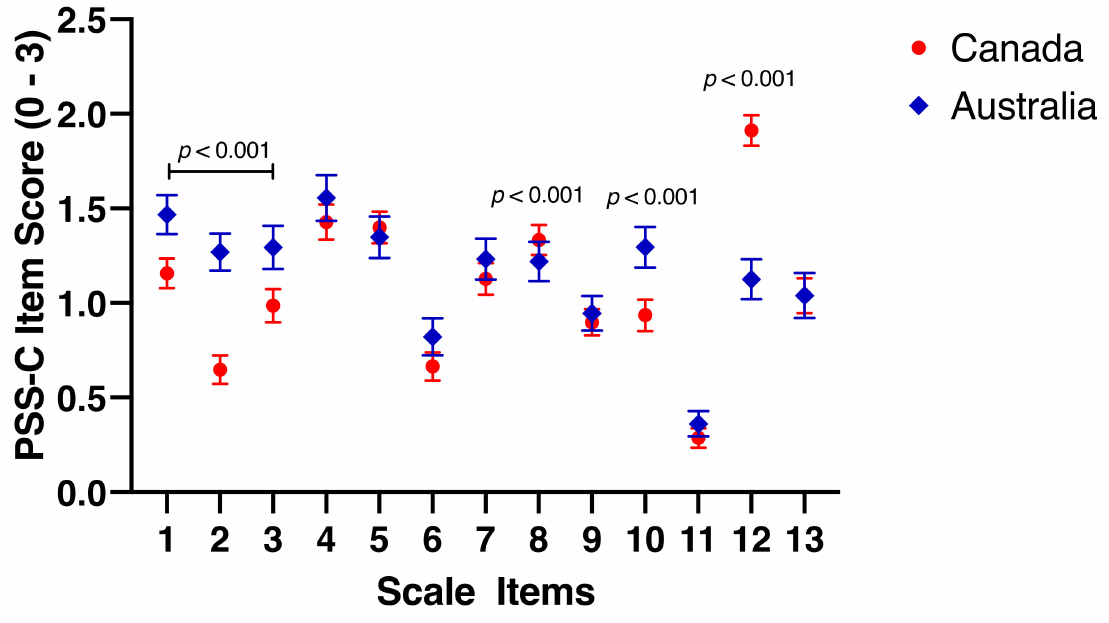
Figure 2. Inter-item Analysis of the PSS-C. Note. Mean (95% CI ) differences between countries on the PSS-C scale